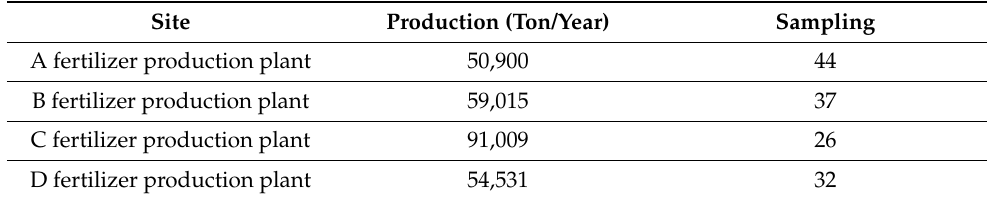
Table 1. Characteristics of the investigated NPK fertilizer production plants.